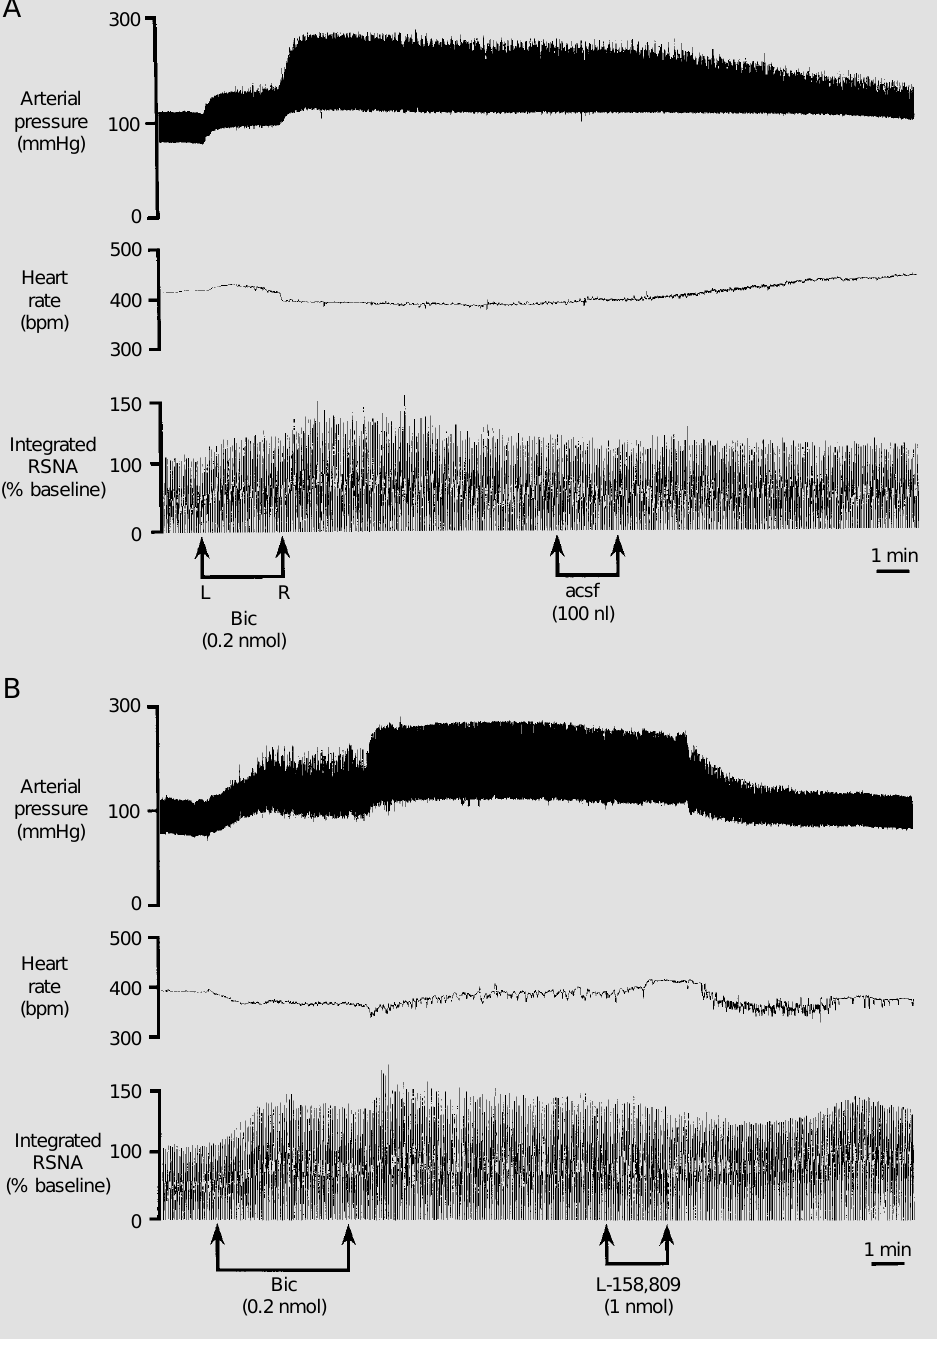
fects on arterial pressure, heart rate and integrated renal sympa- thetic nerve activity (RSNA) evoked by bilateral microinjec- tions into the rostral VLM of ei- ther artificial cerebrospinal fluid (acsf, the vehicle solution) (A) or the AT 1 receptor antagonist L- 158,809 (B) after prior bilateral microinjections of the GABA re- ceptor antagonist bicuculline (Bic) into the same region. The paired arrows indicate the times of the first and second bilateral injections. Note that there was a decrease in arterial pressure, heart rate and RSNA following injections of L-158,809, indicat- ing that there is a tonic excita- tory action on rostral VLM sym- pathoexcitatory neurons medi- ated by AT 1 receptors under con- ditions when GABAergic inhibi- tory inputs are